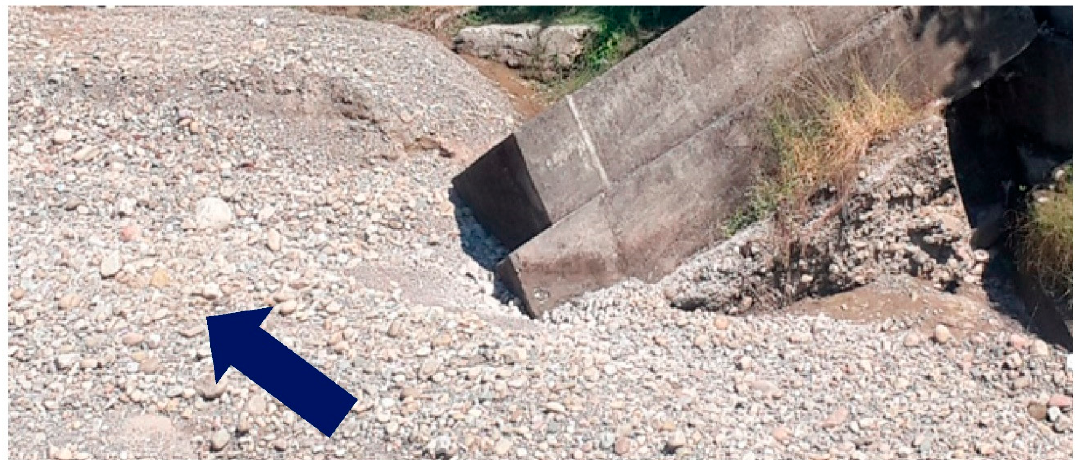
Figure 1. Failure of spur dike at the river Gaula near Haldwani, Uttrakhand in India.